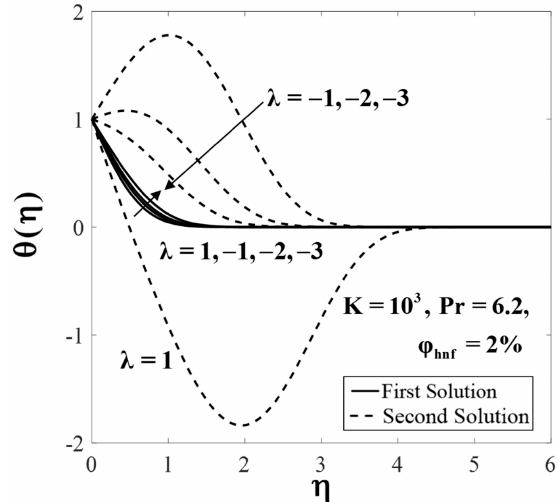
Figure 5. Temperature profiles 𝜃(𝜂) for different values of 𝜆 .